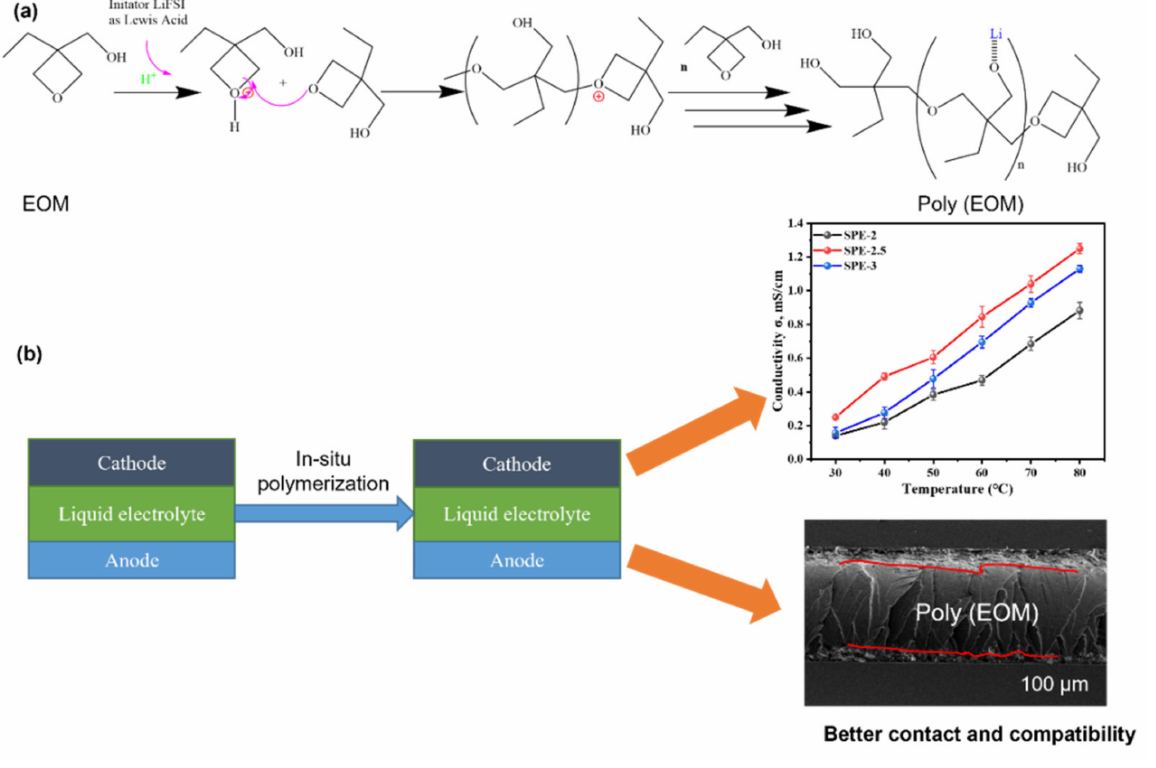
Figure 8. ( a ) Schematic illustration of cationic ring-opening polymerization of poly (EOM), ( b ) ad- vantages of in situ